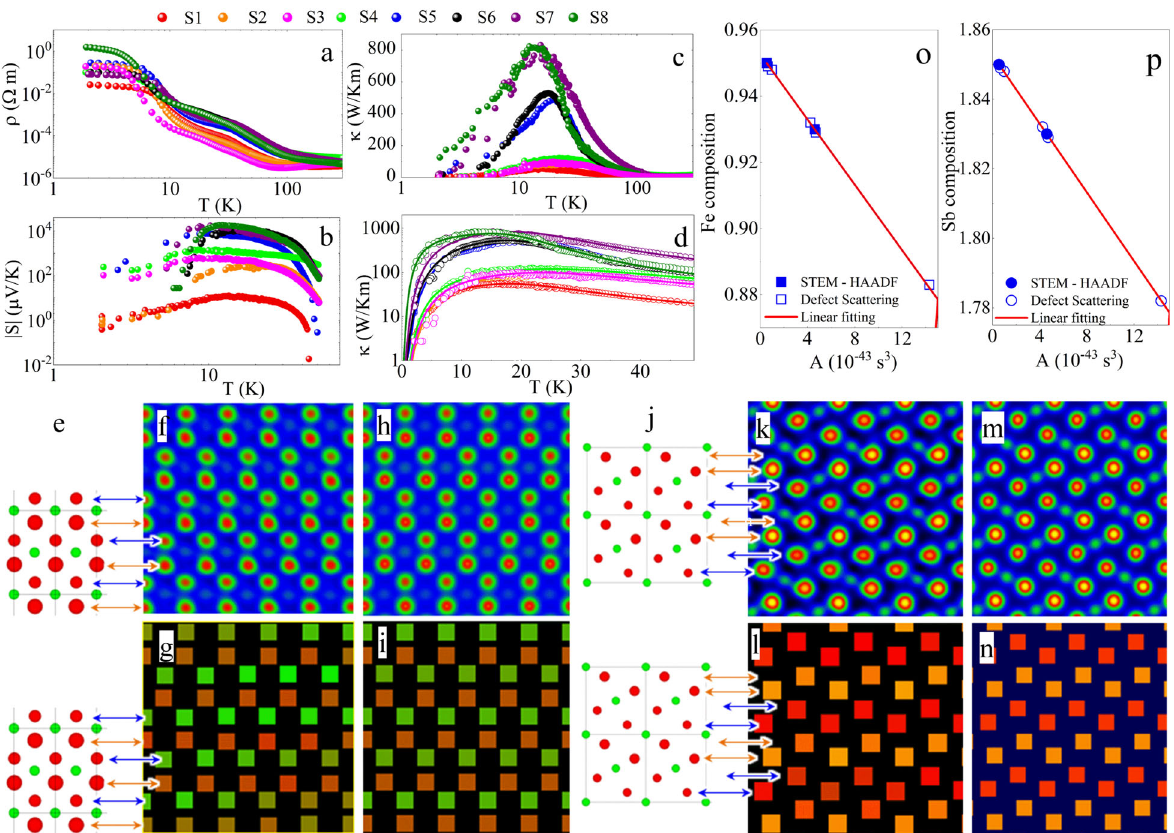
Fig. 2 Relationship between the defect content and transport properties. Temperature dependence of the a electrical resistivity, b thermopower, and c thermal conductivity for the investigated iron diantimonide crystals with different defect content (see text). d Thermal conductivity <50 K. The solid lines show the fi tting by Callaway model. e [100] projection of crystal S3 with green and red spheres representing Fe and Sb atoms. The occupancy of Fe is 0.93. The occupancy of Sb at the row indicated by blue arrow lines is 0.85 (small spheres), while that indicated by brown arrow lines are 0.98 (large spheres). f Magni fi ed image from area II in Fig. 1a. g Sb peak intensity map re fi ned from f . h Simulated image calculated based on multislice method with frozen phonon approximation using structure model in e . i Sb peak intensity map from h . From the simulation, the contrast at Sb site changes with the occupancy of Sb, e.g., the contrast of Sb at the row indicated by blue arrow lines is weaker than that at the row indicated by brown arrow lines. j [001] projection of crystal S8. The occupancy of Fe is 0.95. The occupancy of Sb at the row indicated by blue arrow lines is 0.88, while that indicated by brown arrow lines is 0.97. k Magni fi ed image from area IV in Fig. 1b. l Sb peak intensity map re fi ned from k . m Simulated image based on structure model in j . n Sb peak intensity map from m . From the simulation, the contrast at Sb site changes with the occupancy of Sb, e.g., the contrast of Sb at the row indicated by blue arrow lines is weaker than that at the row indicated by brown arrow lines. o , p present composition of all the investigated crystals in a – c . A is the fi tting parameter in Callaway model as discussed in the main